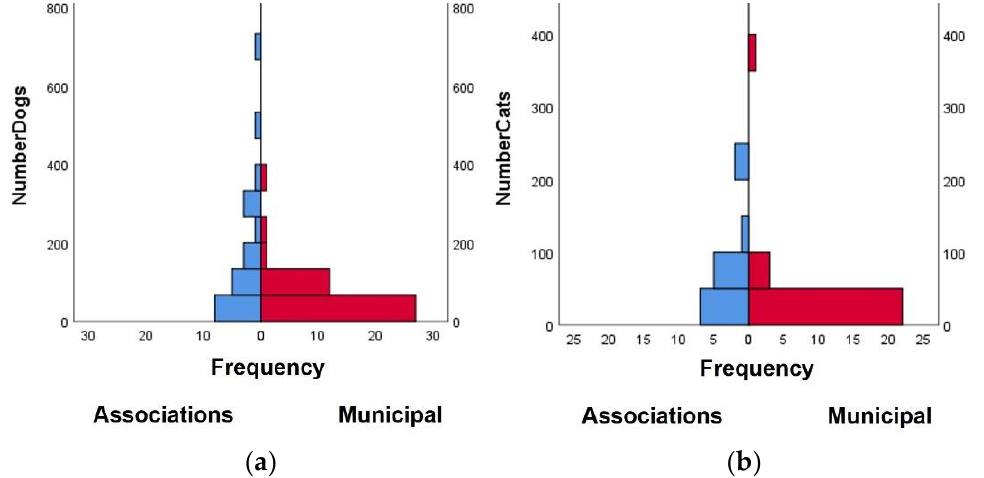
Figure 2. Number of ( a ) dogs and ( b ) cats housed in Association and Municipal animal shelters, as measured by the frequency of questionnaire responses. Data gathered by a questionnaire targeted to Municipal and Non-Municipal shelters (Associations) in March/April 2021.